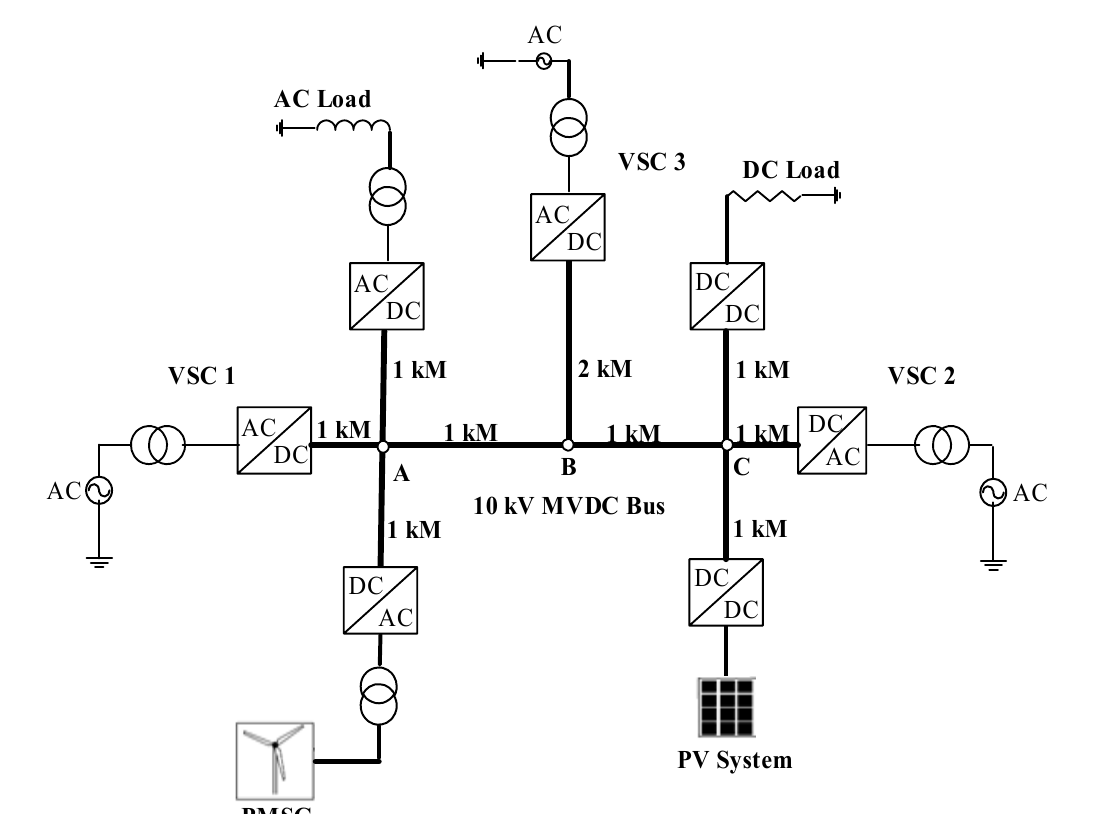
Figure 5. A 10-node radial multiterminal VSC-medium voltage DC (MVDC) distribution network test system.